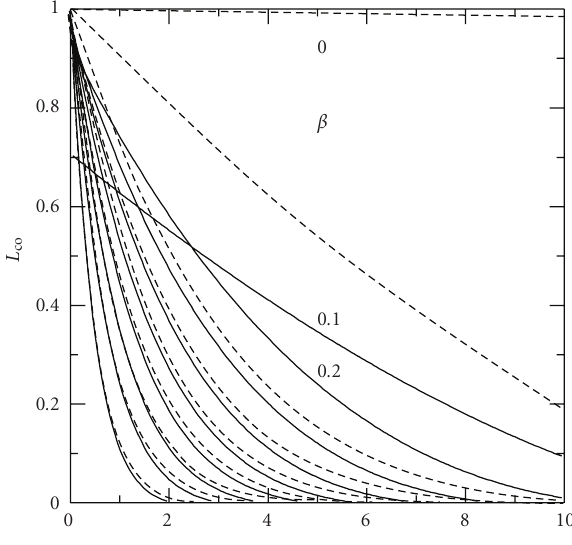
Figure 4: Comoving luminosity for relativistic spherical flows in the LTE case with a uniform source function. The values of β are from 0 to 0.9 in steps of 0.1 from top to bottom. The optical depth τ c at the core radius is set to be 10, and the value of the source function [ κ 0 / ( κ 0 + σ 0 )] W 0 /L s is set to be unity. The solid curves represent the present analytical solutions, while the dashed ones mean the solutions of the homogeneous